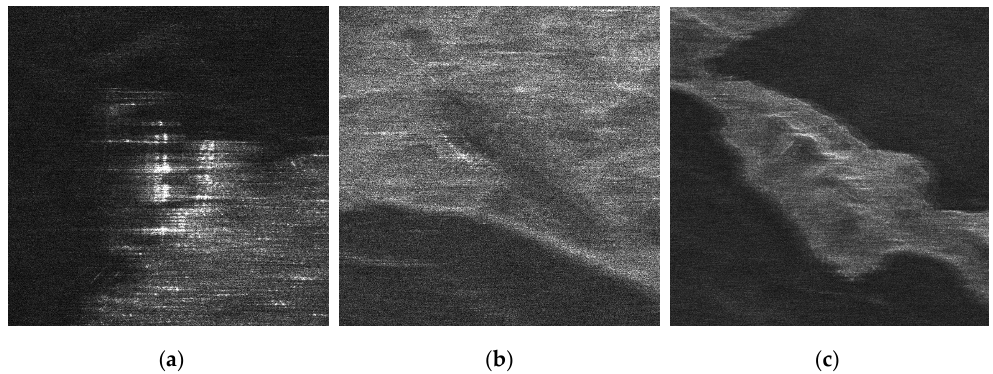
Figure 22. The enlarged view of three areas in the result of BURG algorithm when data is periodically missing along azimuth direction. ( a ) Area A1. ( b ) Area A2. ( c ) Area A3.